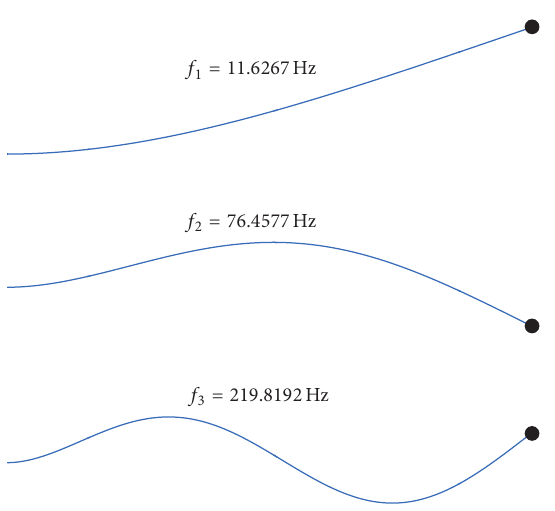
Figure 5: Mode shapes of the cantilever beam with tip mass.